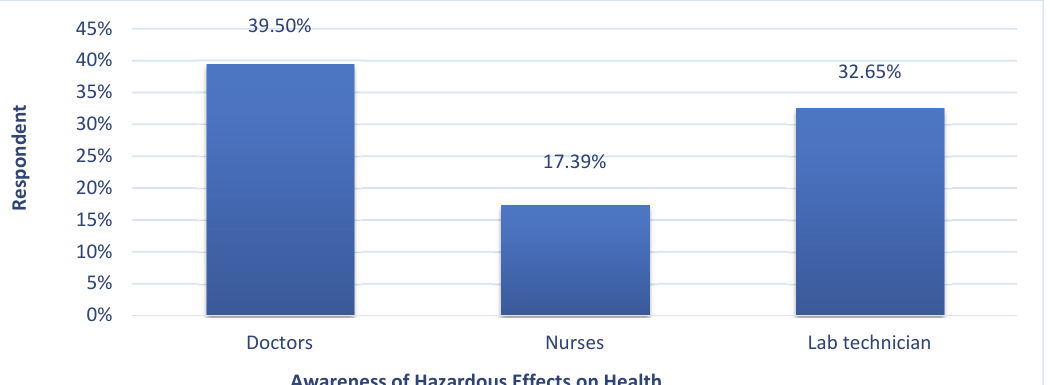
Fig. 11. Effects of Hazardous on